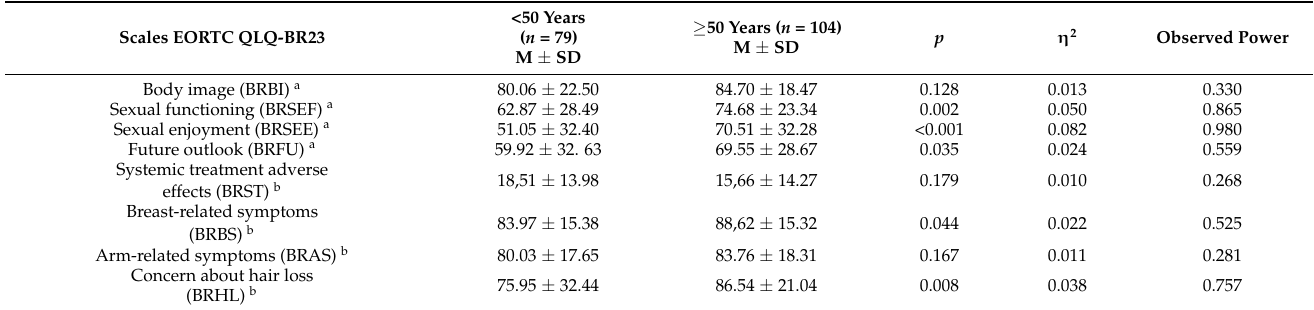
Table 3. Mean score of all items in EORTC QLQ-BR23 of the study group (<50 years vs. ≥ 50 years). Scales EORTC